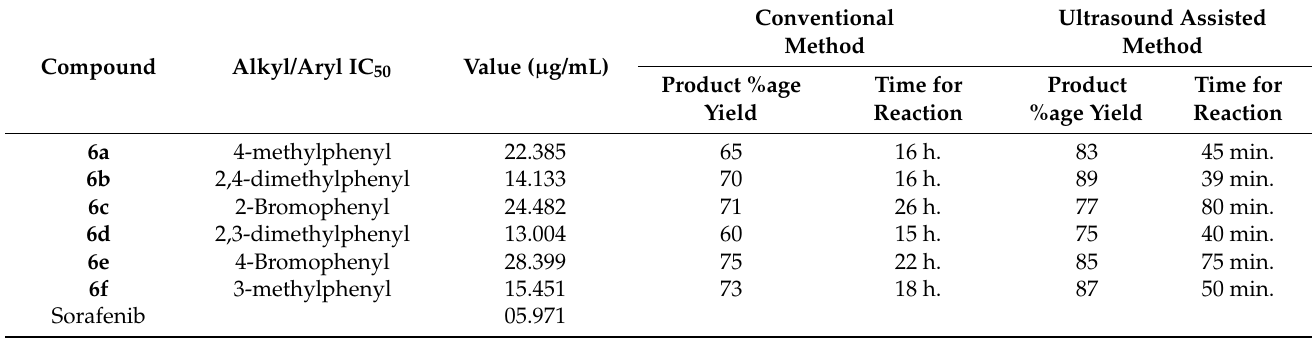
Table 1. The anti-liver cancer activity of triazole-based acetamides 6a–f according to (Scheme